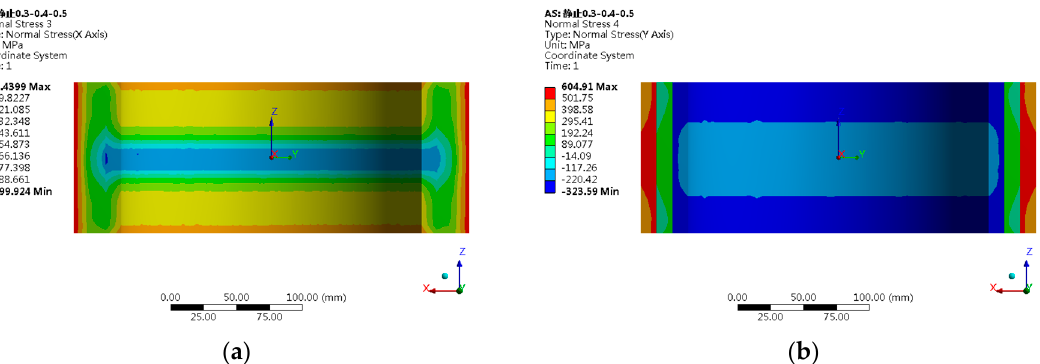
Figure 12. Wheel flange direction stress cloud in a static state. ( a ) Radial stress contour of wheel flange; ( b ) Hoop stress contour of wheel flange.